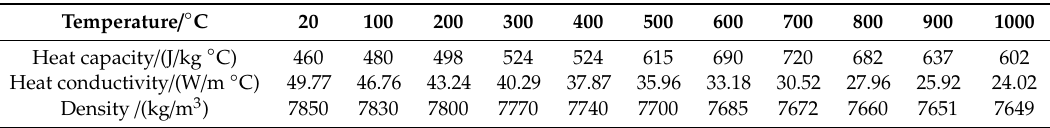
Table 1. Material parameters of 1045